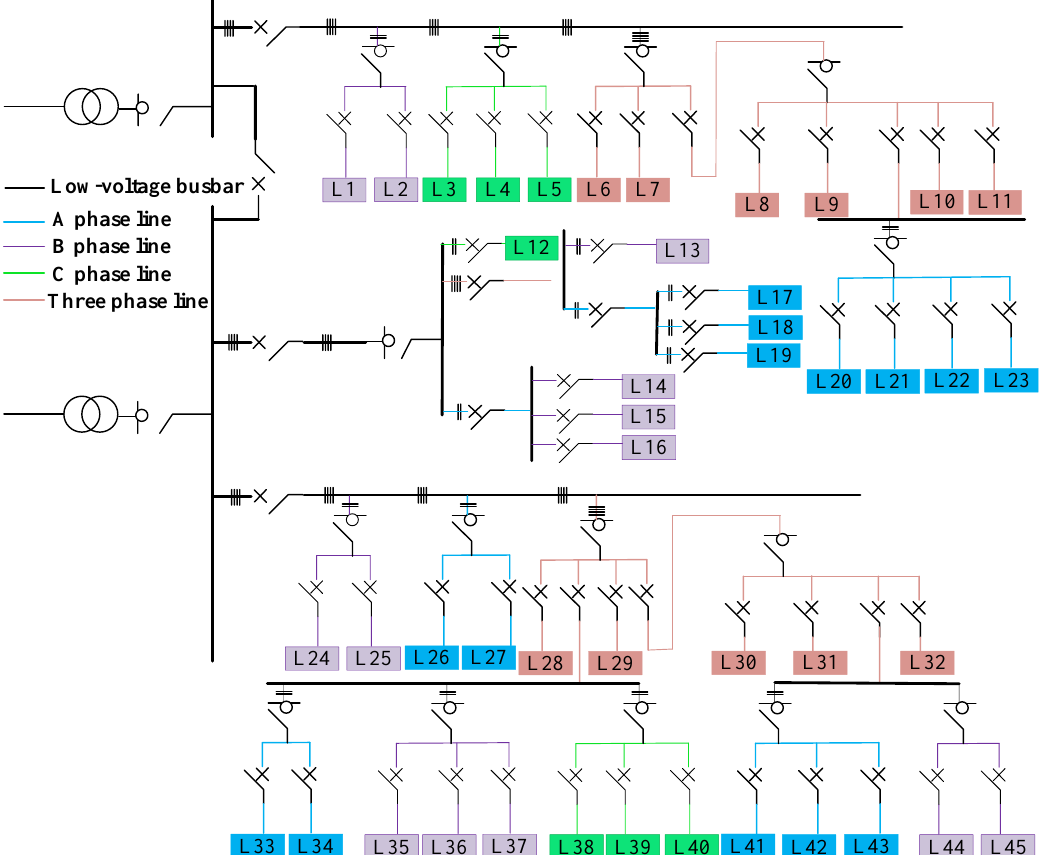
Figure 2. Low-voltage distribution network topology.